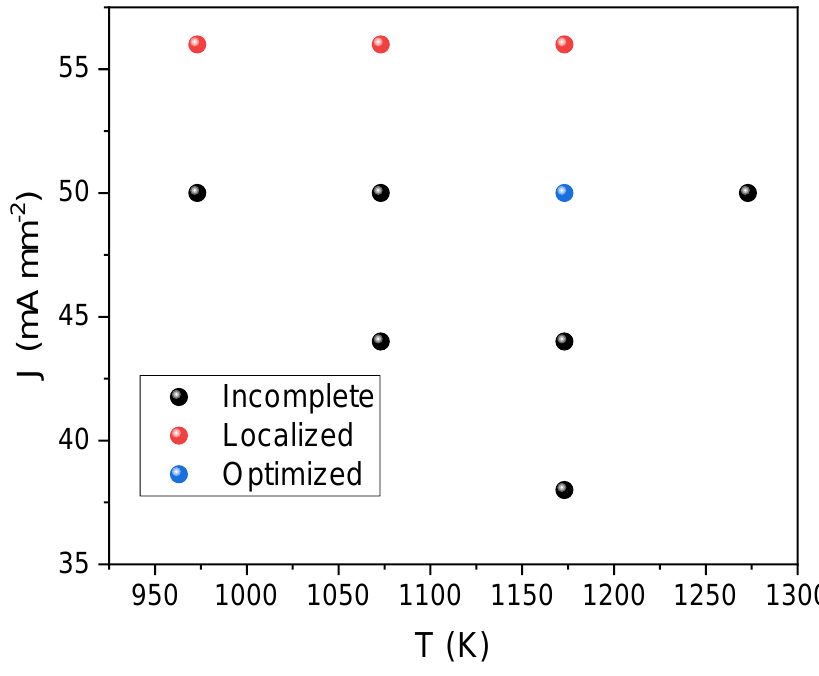
Figure 2. Experimental conditions tested in the reactive flash process of La 2 O 3 and Fe 2 O 3 , in terms of onset temperature and current density limits (flash event holding 10 min).